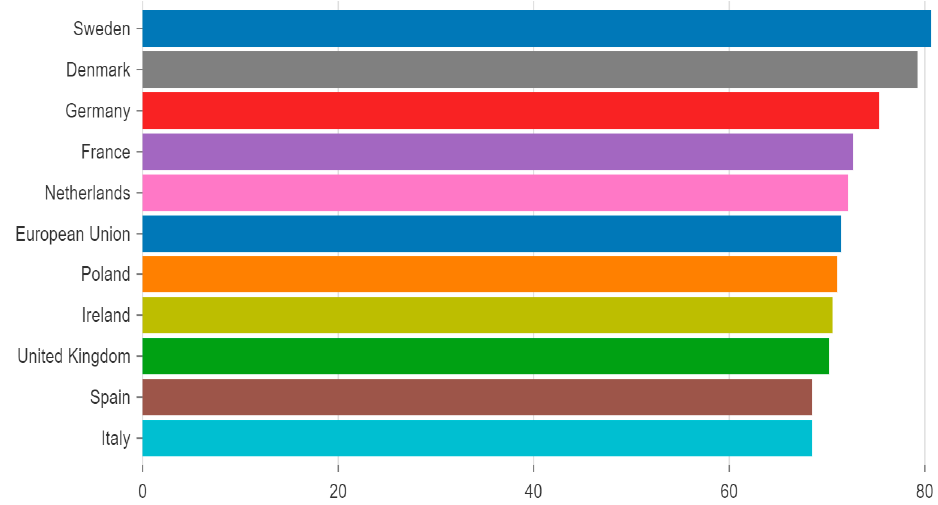
Figure 4. Overall Score for Reaching Sustainable Development Goals. Source: European Sustainable Development Report 2021 Development Report 2021 [63].